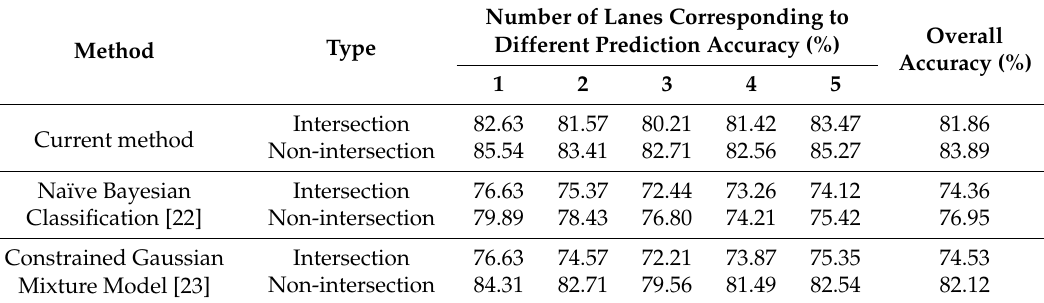
Table 6. Quantitative evaluation of lane number